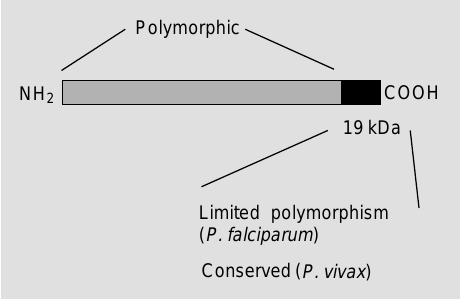
Figure 4 - Schematic representa- tion of merozoite surface pro- tein 1 of Plasmodium